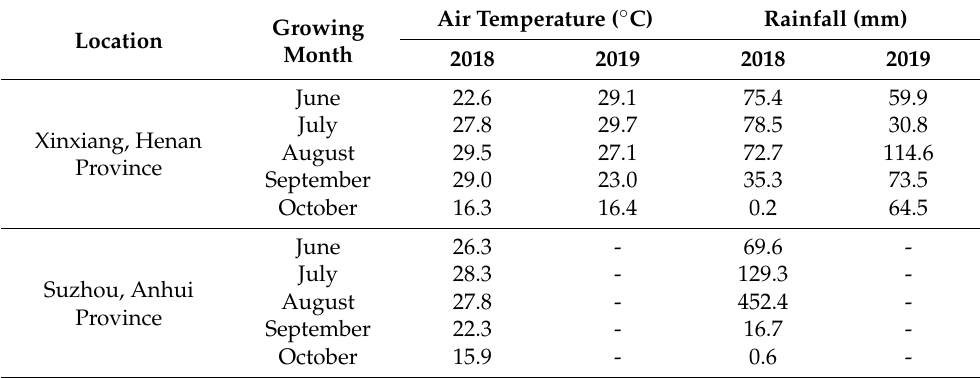
Table 1. Mean monthly air temperature and rainfall during the 2018–2019 growing season. Air Temperature ( ◦ C) Rainfall Growing Location Month